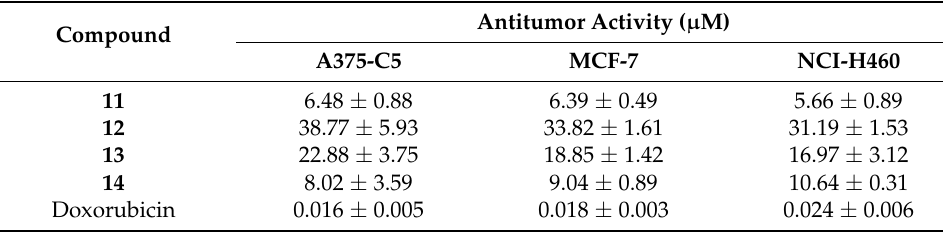
Table 2. Cell growth inhibitory activity of compounds 11 – 14 .